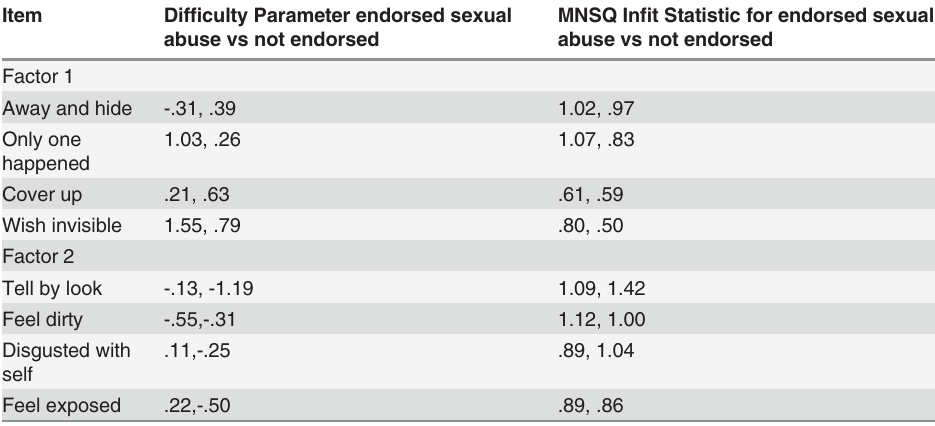
Table 5. Sub-Analysis: Multidimensional Rating Scale Model with Unstandardized Parameters for Girls who Endorsed Sexual Abuse vs. Unidimensional Rating Scale Model with Unstandardized pa- rameters for Girls who Did Not Endorse Sexual